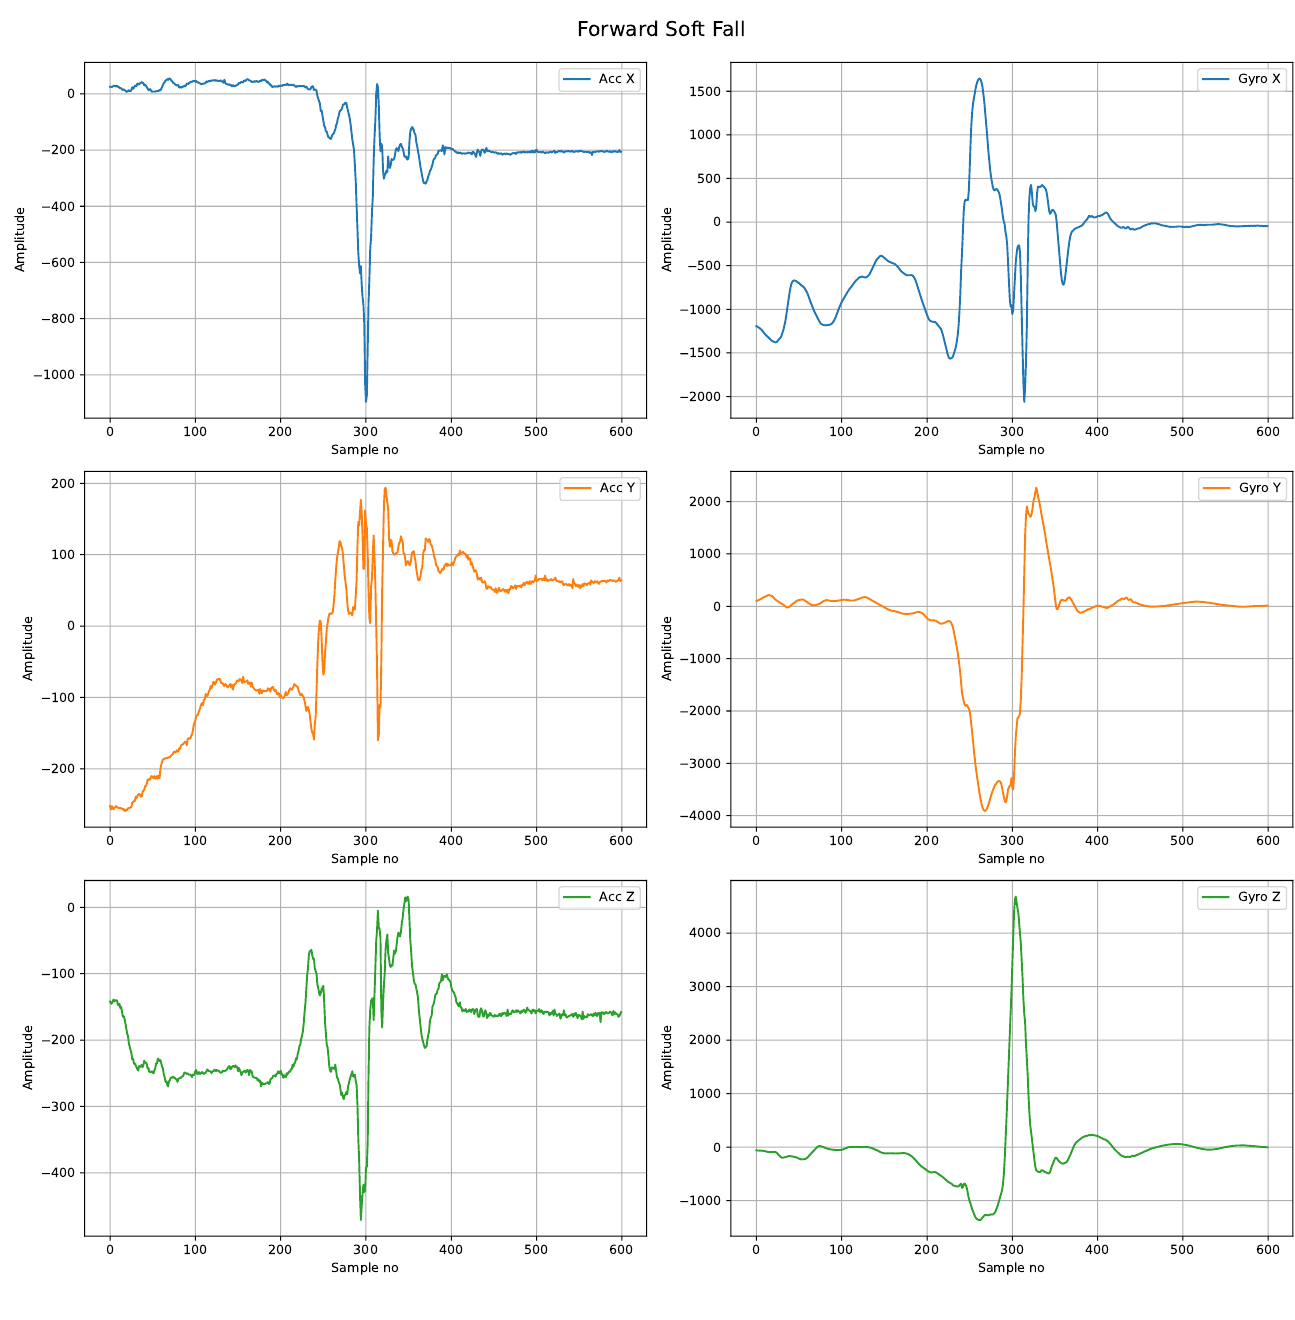
Figure A2. Sample of forward soft